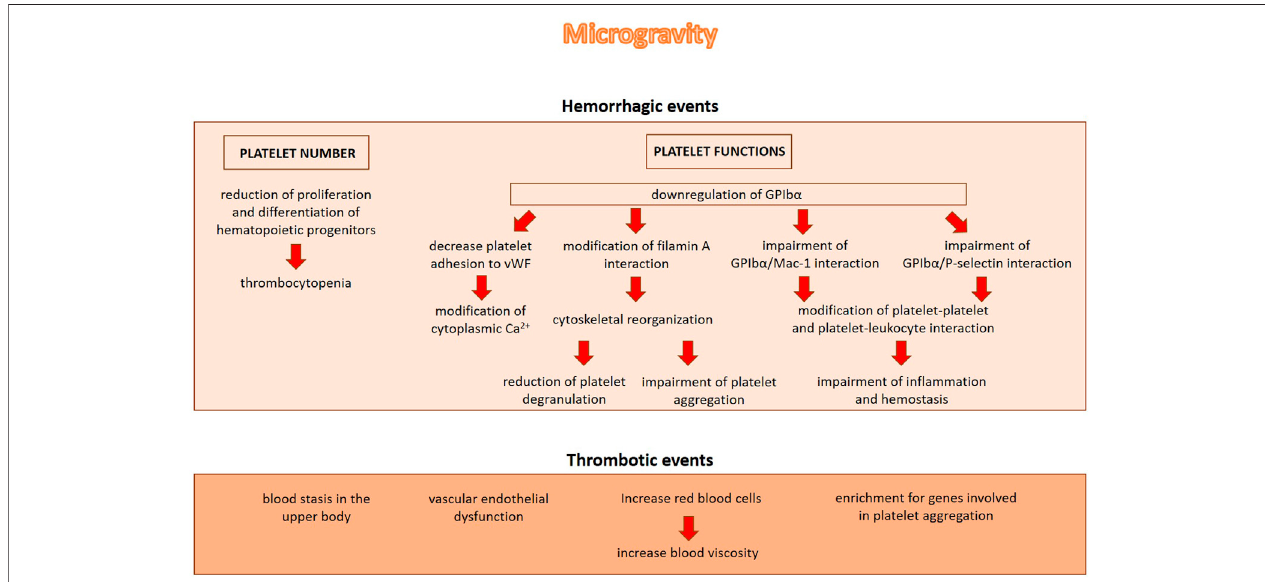
FIGURE 2 | The role of microgravity in inducing hemorrhagic or thrombotic events. Microgravity induces hemorrhagic events by decreasing platelet number and impairingplateletfunctions.Ontheotherhand,microgravityinducesbloodstasisintheupperbody,vascularendothelialdysfunctionandalterationsinbloodvolumeand blood viscosity, all events which might contribute to the increase of thrombotic